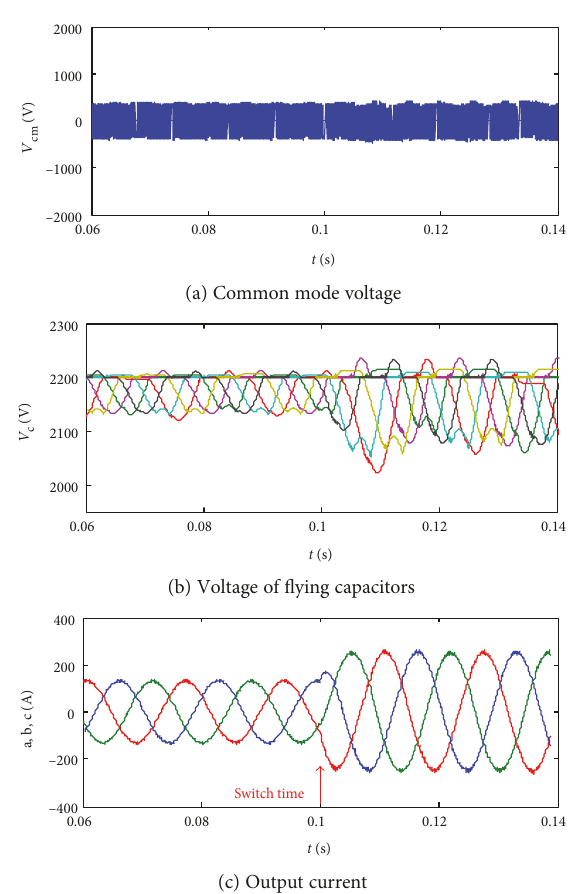
Figure 8: Simulation results from half to full load.